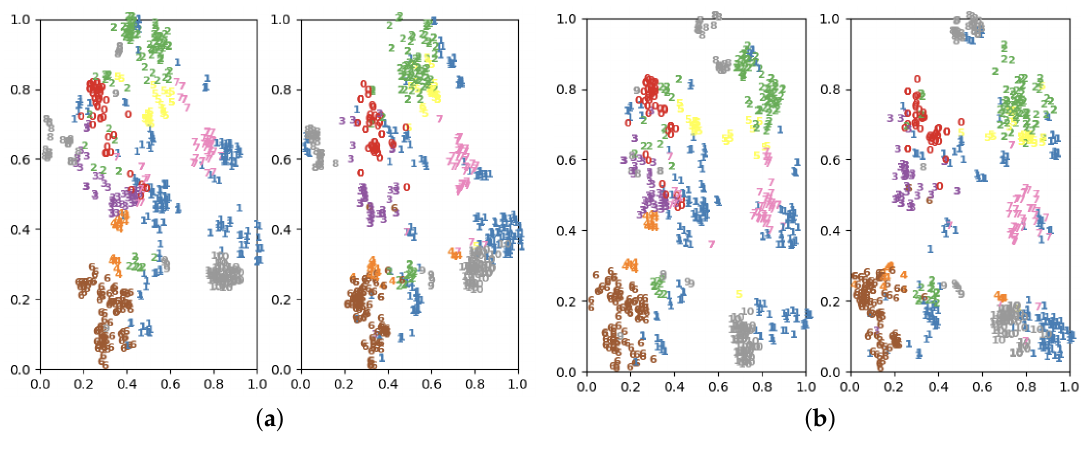
Figure 7. Data distribution under different relation types. ( a ) Original data distribution of source domain (left) and target domain (right). ( b ) Data distribution of source domain (left) and target domain (right) under our method.